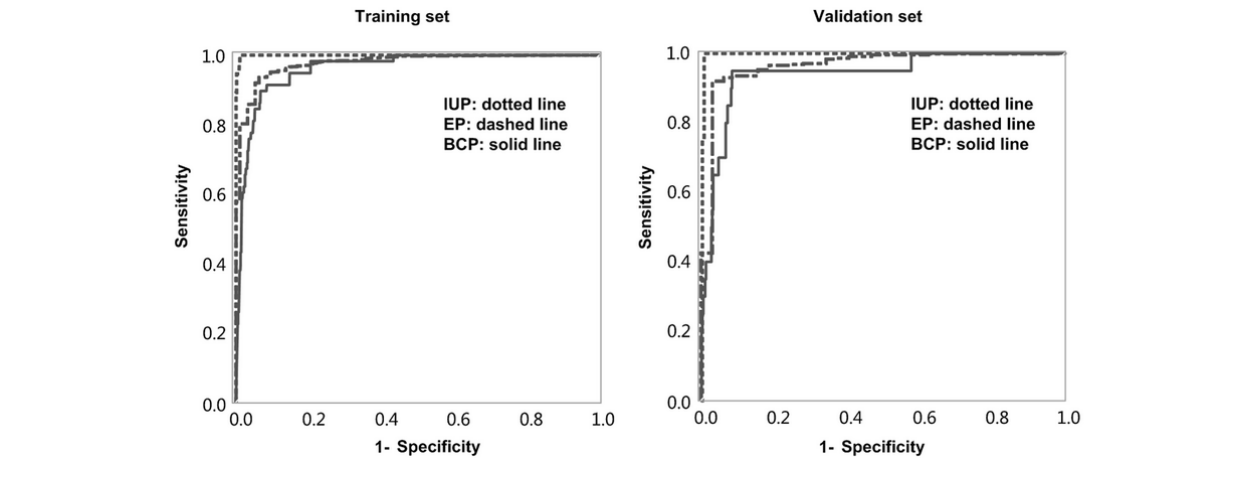
Figure 2. Sensitivity and specificity of the model in the training and validation sets.